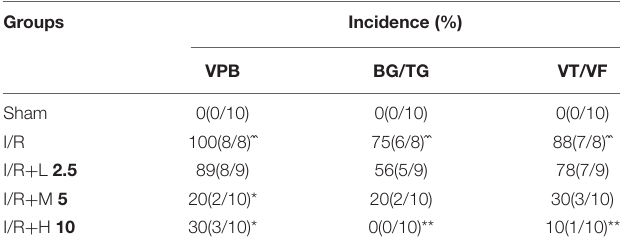
TABLE 2 | Effect of LS-102 on the incidence of cardiac arrhythmias in the rat.